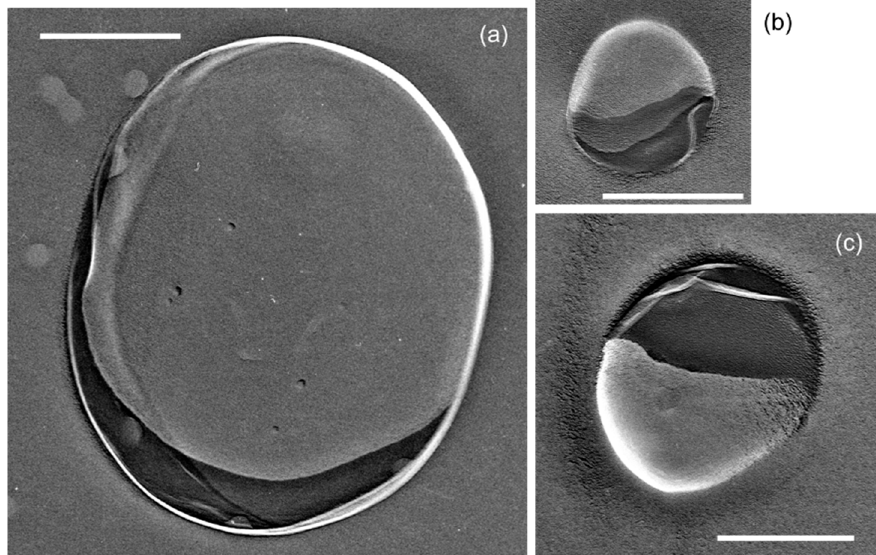
Figure 1. Typical TEM images of UFBs in the CO 2 -hydrate-dissociation water. ( a ) Relatively large size UFB, ( b ) Normal size UFB with thin layer on the surface, ( c ) Normal size UFB surrounded by the liquid phase different from pure water. (scale bars: 300 nm).